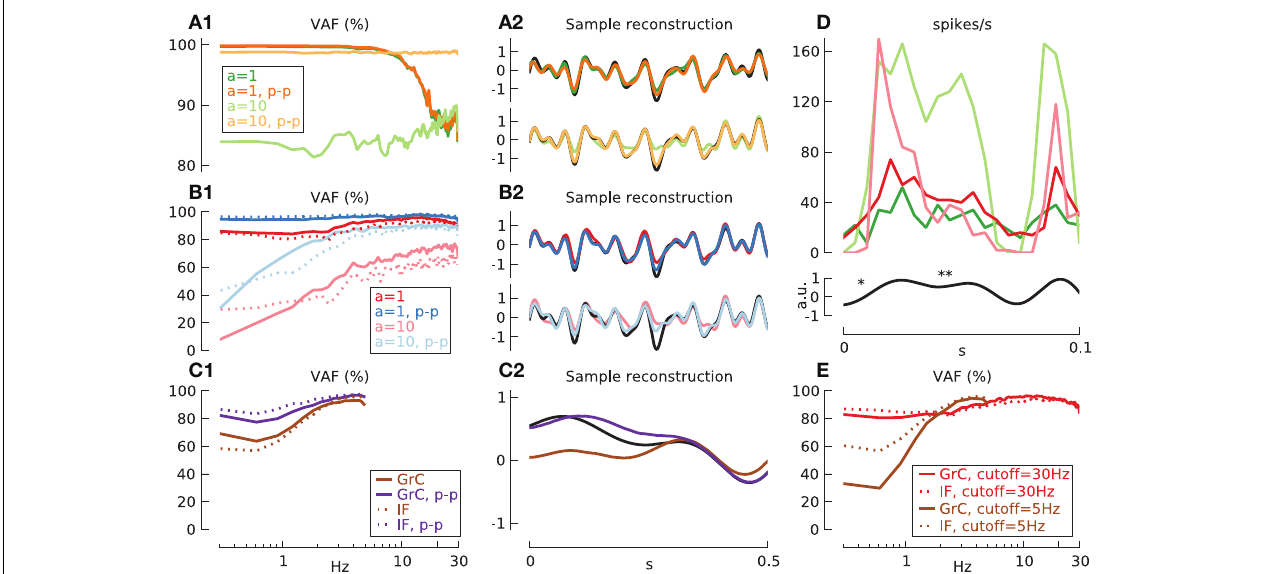
push-pull: dotted light blue lines (20.8/6.0/84.5). (C) Input (cutoff = 5Hz) through synaptic excitation, m ( F 0 in ) = 40 spikes/s, a = 1 and low